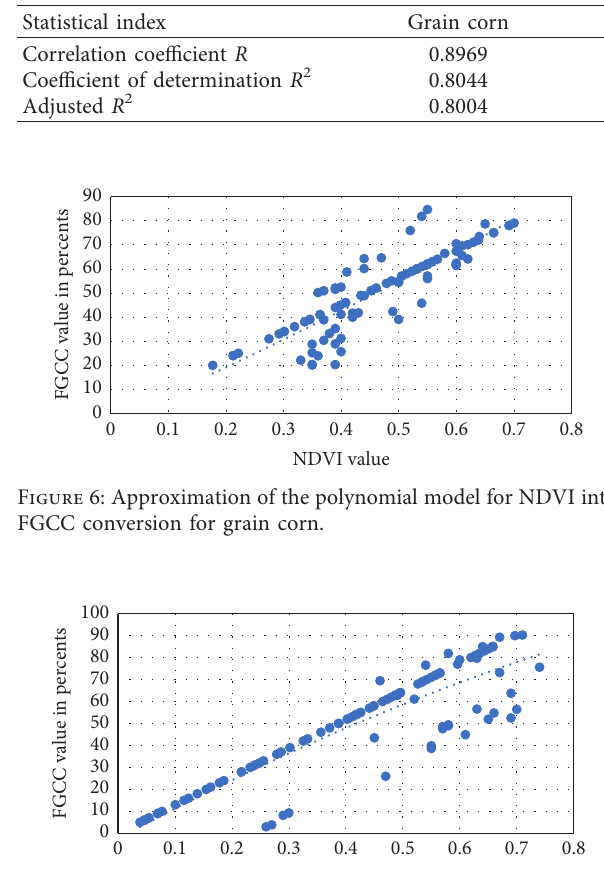
Table 3: Regression statistics for the developed models of NDVI into FGCC conversion for the studied crops.